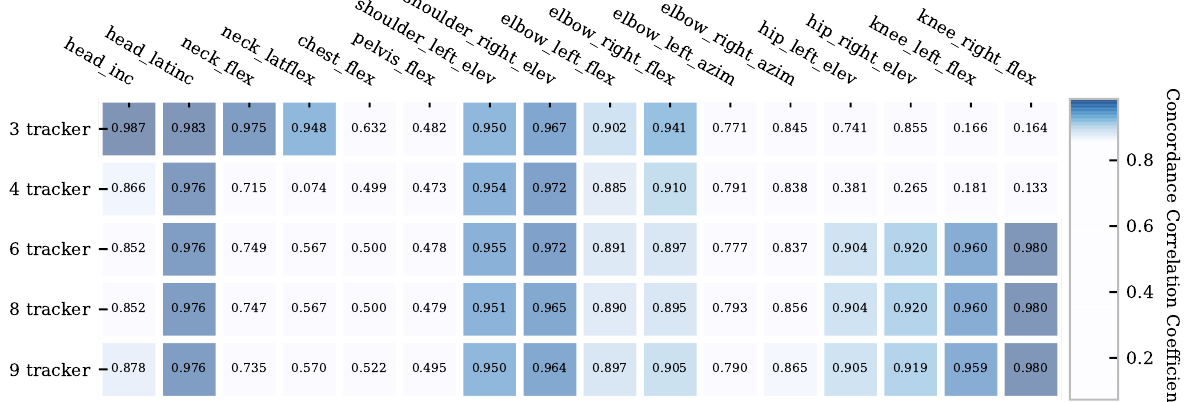
Figure 11. Concordance correlation coefficient for all studied joint angles and tracker